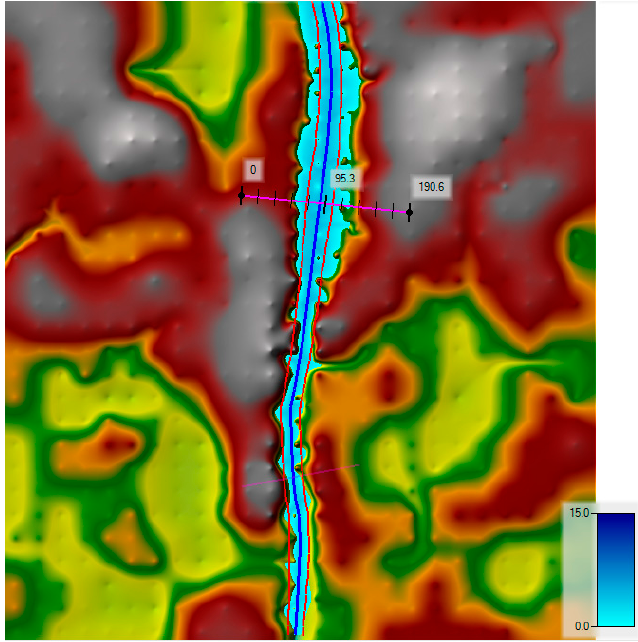
Figure 10. Flood simulation for Q 100 using Ras Mapper interface.